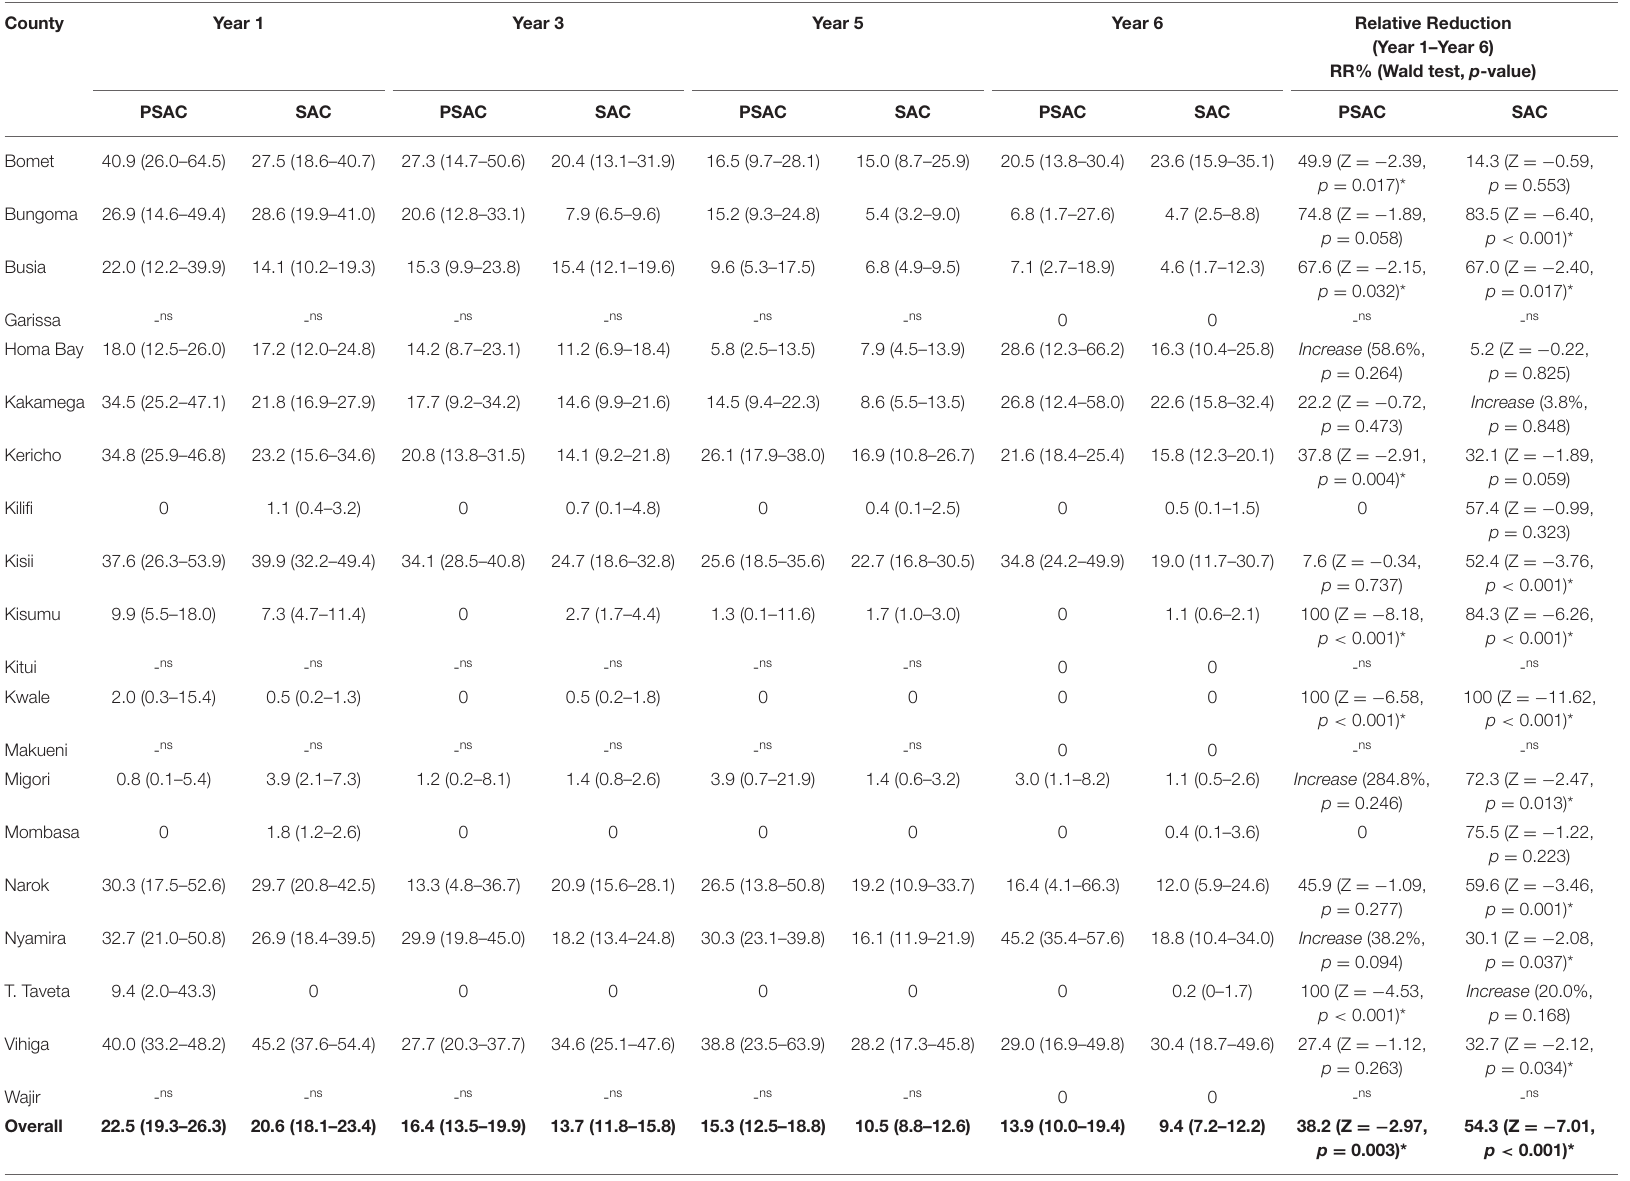
TABLE 3 | Preschool (PSAC) and school (SAC) aged pre-treatment prevalence % (95% CI) and relative reductions % (Wald test: Z-statistic, p -value) for Ascaris lumbricoides infection in 20 counties in